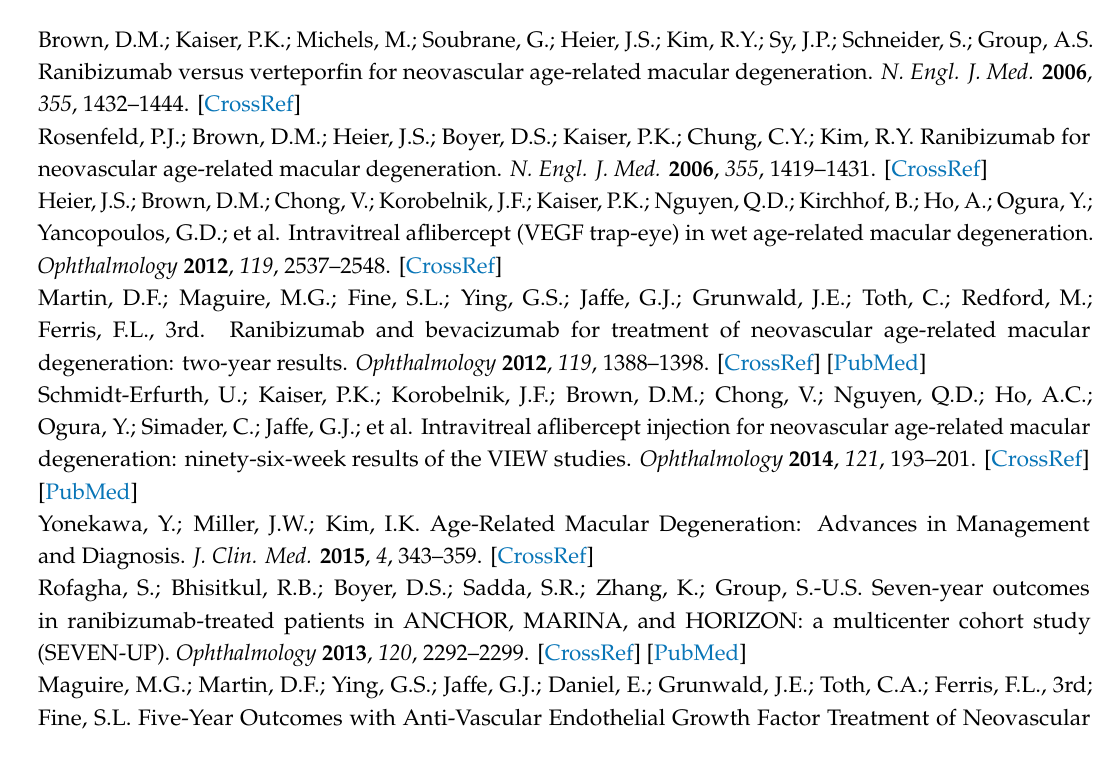
Summary: We analyzed whether fovea-involving OCTA-proven fibrovascular PED has a protective e ff ect on the surrounding photoreceptor area by comparison with subretinal CNV. We found that subretinal fibrovascular PED did not have an additional protective e ff ect on the outer retina over 2